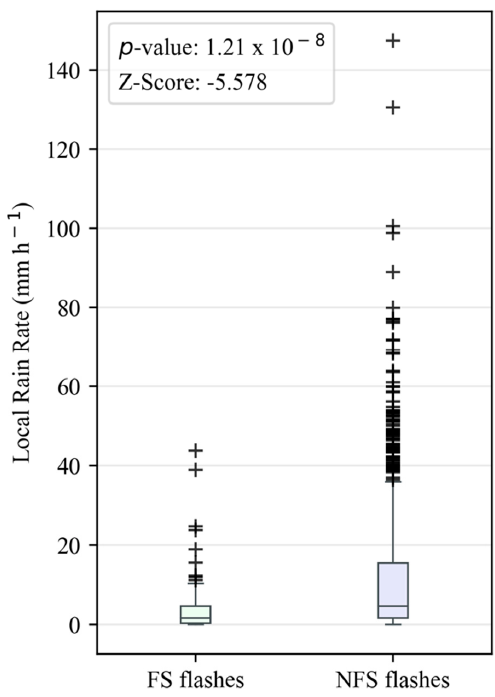
Figure 4. Distributions of rain rates at FS and NFS flash locations.